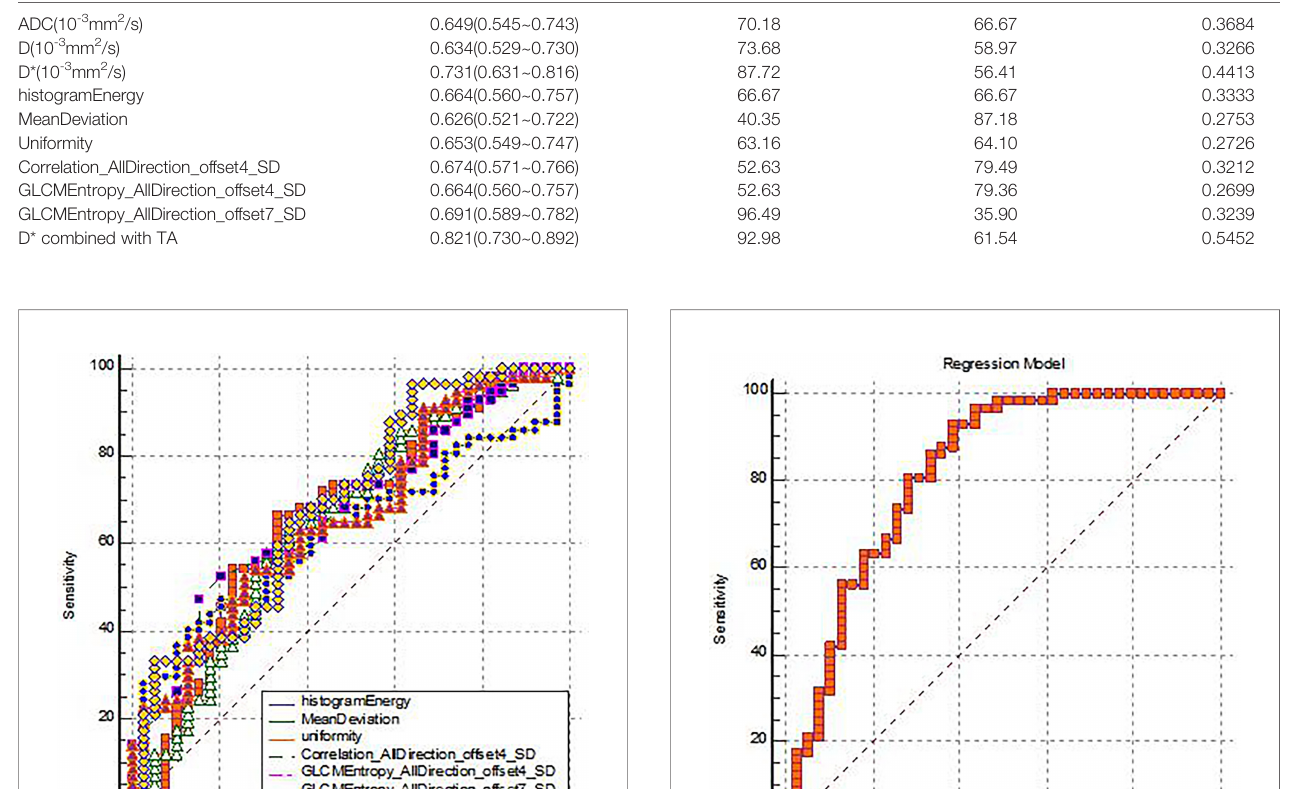
TABLE 3 | The ROC analysis for each individual feature, and IVIM-DWI combined with TA.